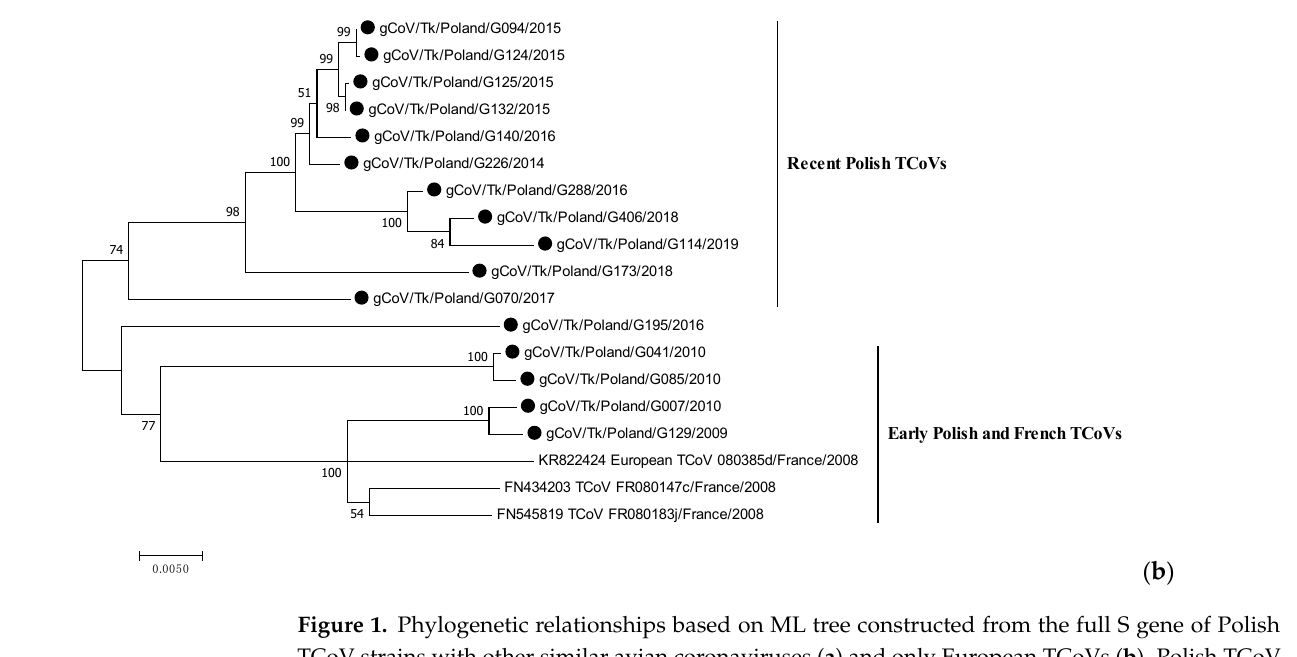
Figure 1. Phylogenetic relationships based on ML tree constructed from the full S gene of Polish TCoV strains with other similar avian coronaviruses ( a ) and only European TCoVs ( b ). Polish TCoV strains are marked with a black dot. Sequence analysis of the full S gene revealed that Polish TCoV strains shared a nu- cleotide identity of 94.3–100%. Nucleotide homology between strains of Group 1 was 96.5– 100% and between them and the European reference 080385d/2008 strain, it was 94.7– 96.6%. In turn, the similarity of TCoVs from Group 2 was 95.2–99.5% and showed a 95.8– 98.2% identity when compared with the European reference strain 080385d/2008 (Table 3). Table 3. Sequence identity of S gene of Polish TCoVs and European reference strains from France.